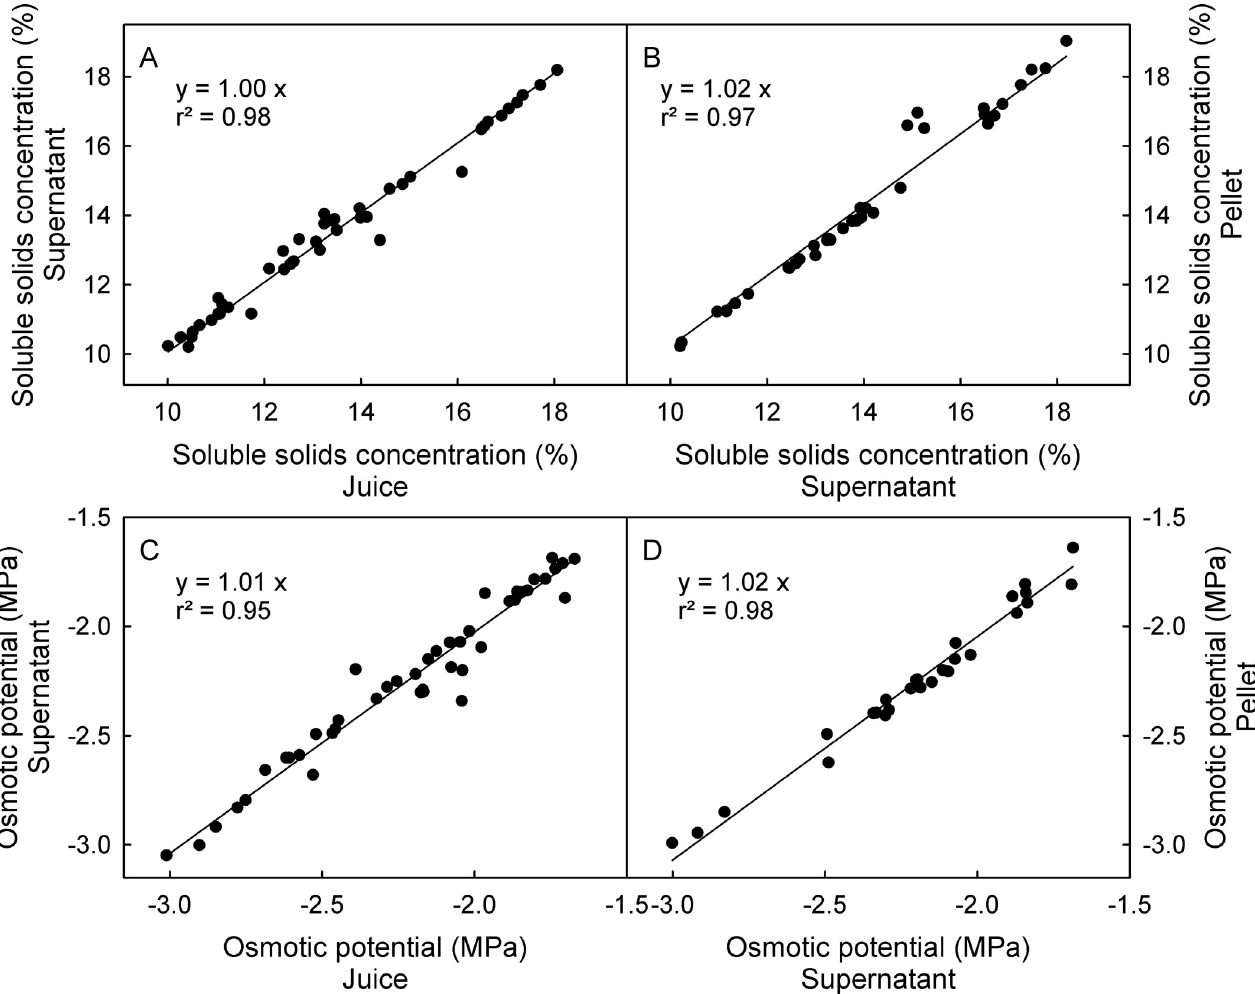
Fig 2. Relationships between the soluble solids concentration (A-B) or the osmotic potential (C-D) with and without centrifugation . Soluble solids concentration of sweet cherry juice without centrifugation vs. the supernatant (A) or pellet (B) of the same juice following centrifugation. Osmotic potentials of juice without centrifugation vs. the supernatant (C) or pellet (D) of the same juice following centrifugation. The juice was obtained by pressing pitted fruit. Osmotic potentials were determined by vapor pressure osmometry and the soluble solids concentration by